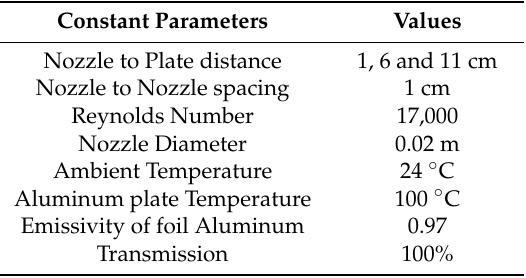
Table 1. Constant values in the numerical and experimental